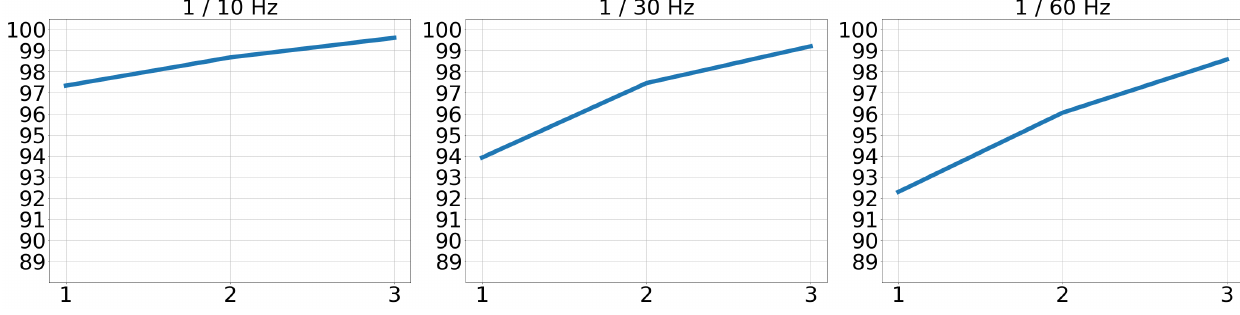
Figure 6. PCA—Variance ratio explained vs number of